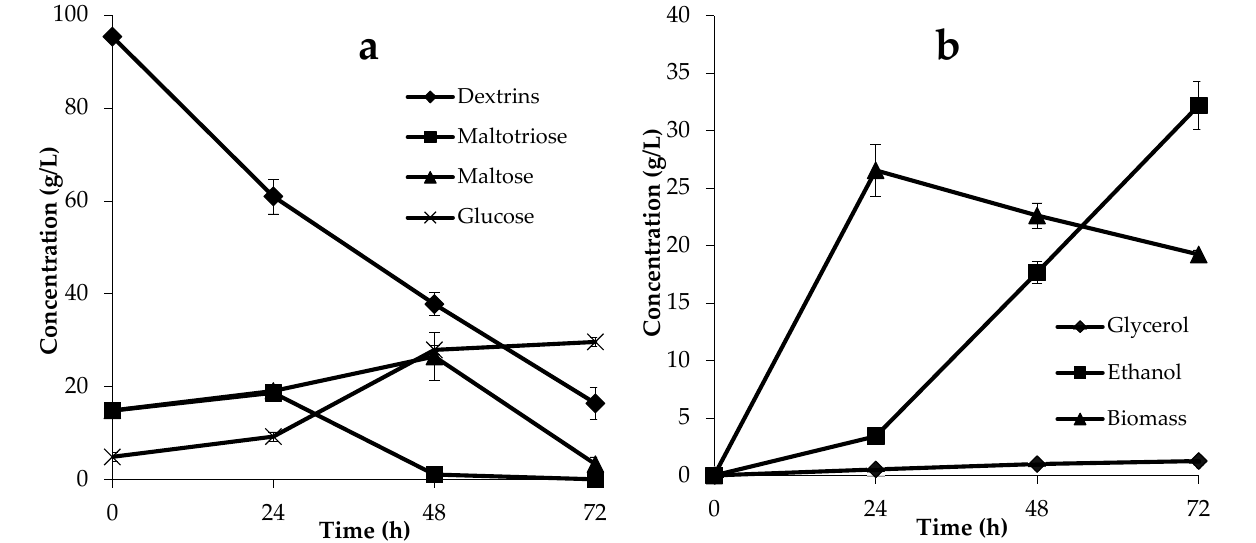
Figure 1. Concentration profiles of ( a ) carbohydrate utilization and ( b ) production of ethanol, glycerol and biomass during N. intermedia cultivation on bread waste hydrolysate. Results are average values ± one standard deviation ( n = 2).